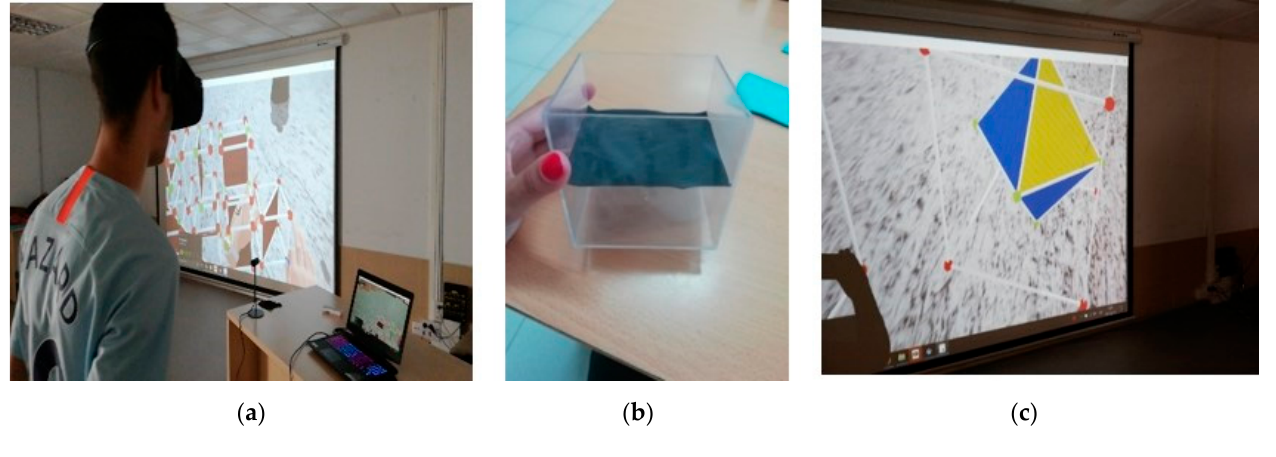
Figure 11. ( a ) student doing planes of symmetry with NeoTrie VR; ( b ) student doing planes of symmetry with manipulative materials; ( c ) dual solid hexahedron-octahedron made with NeoTrie VR by students.